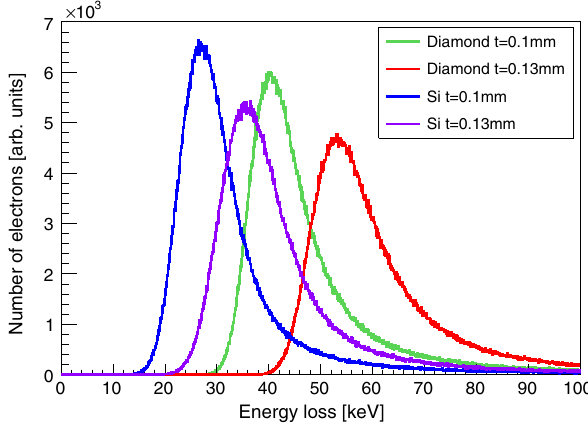
FIG. 10. Electron ’ s energy loss after the electron beam of 75 MeV passes through Si and diamond crystals of different thickness. Symbol t in the legend means crystal